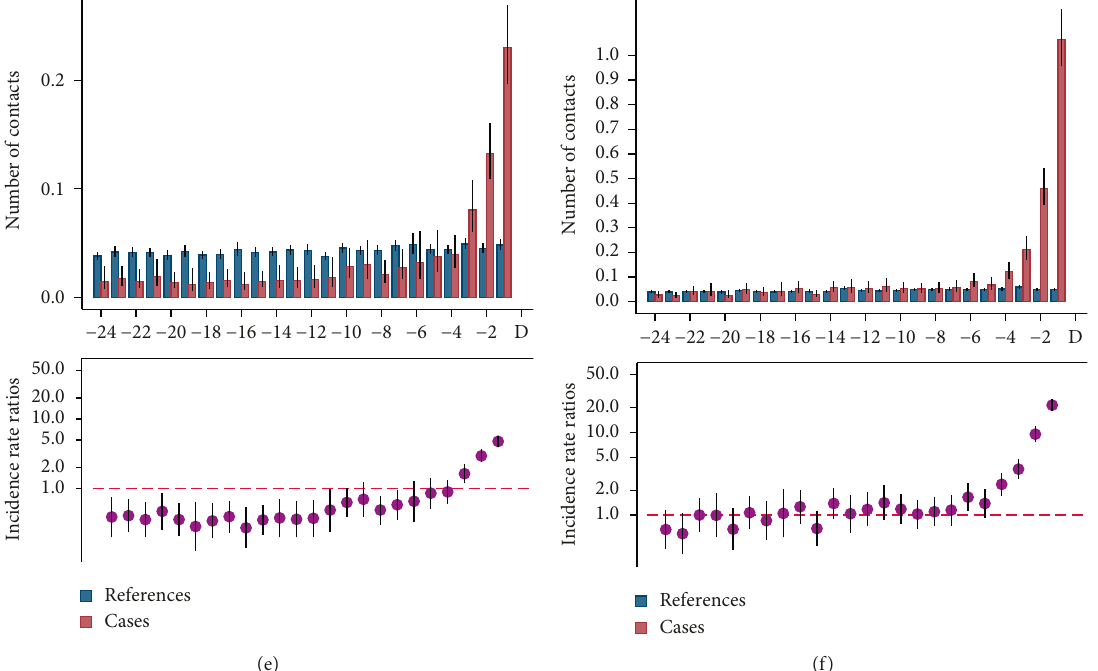
Figure 2: Monthly rates and incidence rate ratios (IRRs) for use of health care services among references and cases in (a) general practice, (b) inpatient visits, (c) outpatient visits, (d) paraclinical examinations, (e) surgery, and (f) diagnostic imaging for cases and references 24months before the sarcoma diagnosis, with 95% confidence interval (CI). Note the differences in the Y -axis range.